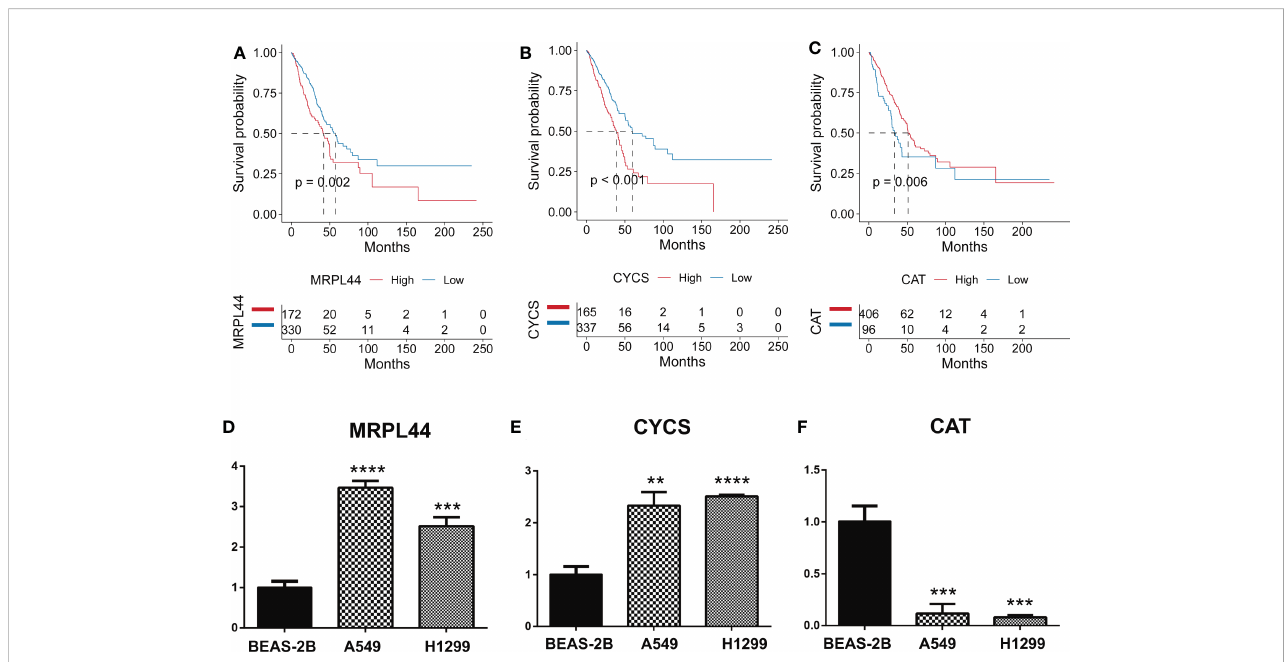
FIGURE 8 Quantitative Real-time PCR. (A – C) Kaplan-Meier curves displaying the correlation between the expression of the signature genes, including MRPL44 (A) , CYCS (B) , and CAT (C) , and the survival status of LUAD patients. The blue curve represents the patients with lower gene expression, and the red curve represents patients with higher gene expression. (D – F) Quantitative Real-time PCR assays using cell lines for MRPL44 (D) , CYCS (E) , and CAT (F) . **p<0.01, ***p<0.001,